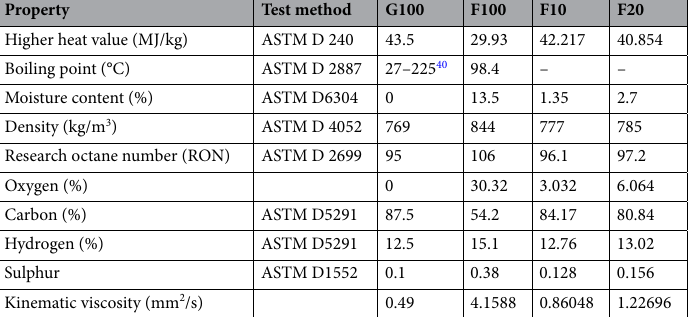
Table 4. Properties of fusel oil.